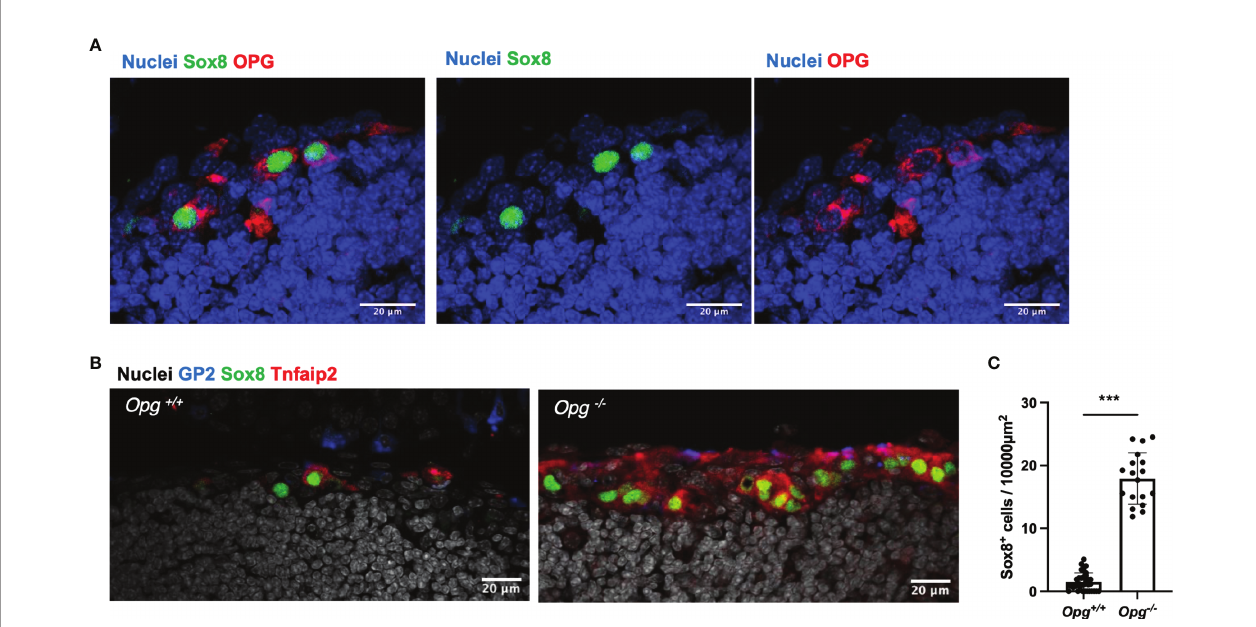
FIGURE 5 | OPG suppresses the differentiation of M cells in TALT. (A) Sox8 (green) positive cells express OPG (red) in TALT FAE of BALB/c mice. Nuclei were stained with Hoechst 33342 (blue). Bars: 20 µm. Representative images of those obtained from at least 3 animals are shown. (B) Immuno fl uorescence images of GP2 (blue), Sox8 (green), and Tnfaip2 (red) in the FAE of TALT in the Opg +/+ or Opg -/- mice. Nuclei were stained with Hoechst 33342 (gray). Bars: 20 µm (C) Quanti fi cation of the frequency of Sox8 + cells in the FAE of TALT. Data were presented as the mean ± standard deviation. *** P < 0.001 (Mann-Whitney U test, n = 3 animals, respectively). The individual dot represents the number of Sox8 + cells per 10,000 µm 2 of